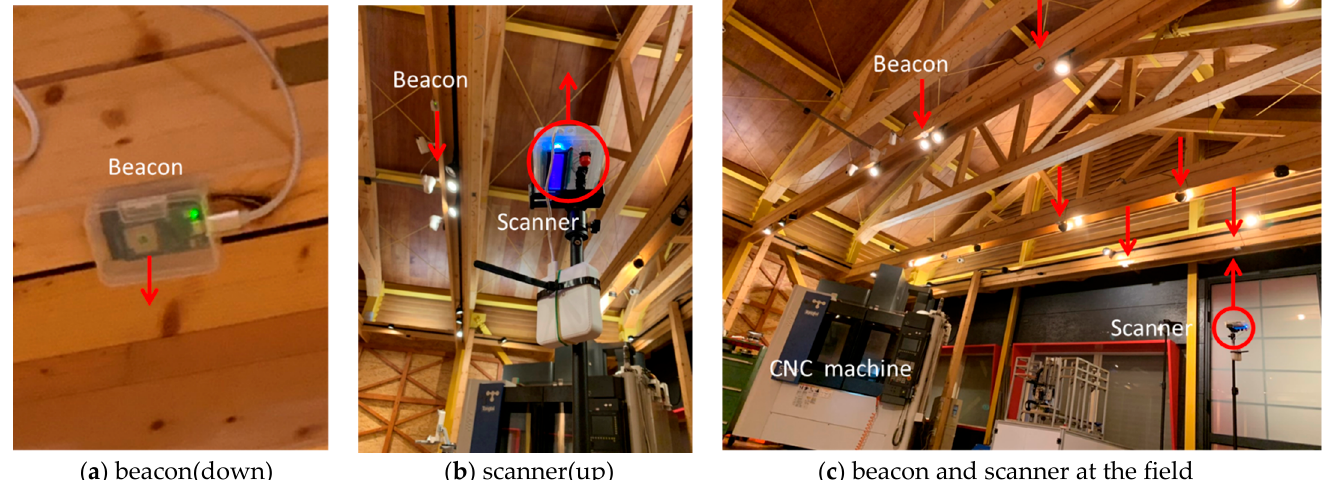
Figure 6. Measurements scene at the workshop.